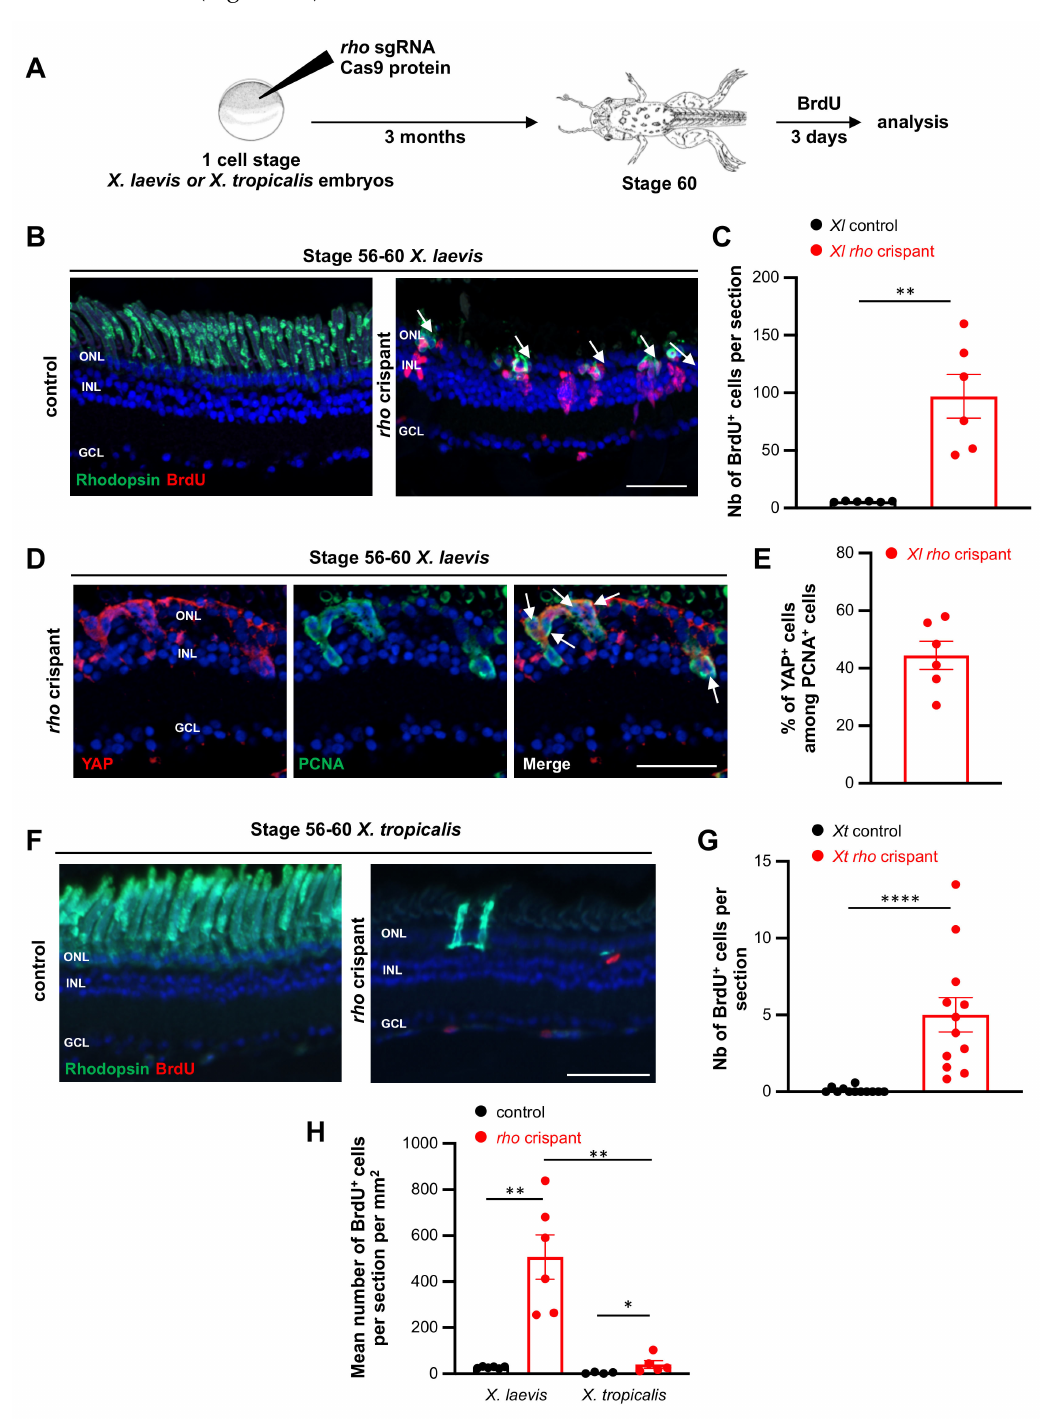
Figure 6. Analysis of proliferation in X. tropicalis and X. laevis rho crispants. ( A ) Timeline dia- gram of the experimental procedure used in ( B – H ). ( B , C ) BrdU assay on retinal sections from stage 56–60 control and crispant X. laevis tadpoles. Sections were co-labelled for Rhodopsin. Arrows point to double positive cells. BrdU-positive cells are quantified in ( C ). ( D ) Typical sections from stage 56–60 crispant X. laevis tadpoles, immunostained for PCNA (a marker of proliferative cells) and